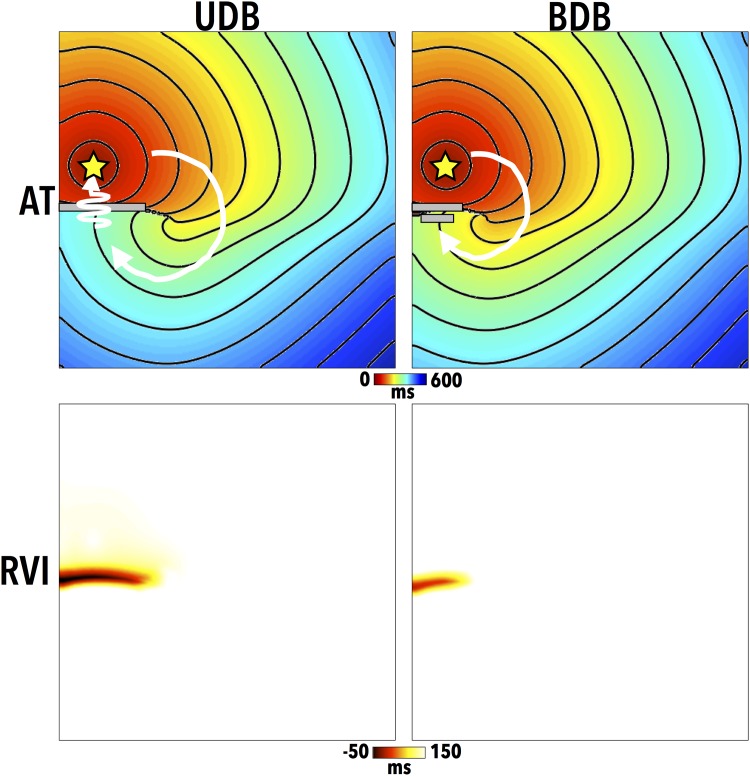
AT maps (top) for the premature S2 beat, along with computed RVI maps (bottom) for cases of both uni-directional block (UDB) and subsequent successful reentry (left) and bi-directional block (BDB) and failed reentry (right).Grey lines highlight approximate lines of initial conduction block, with white arrows highlighting wavefront paths. Pacing locations are shown by a yellow star in the AT maps.